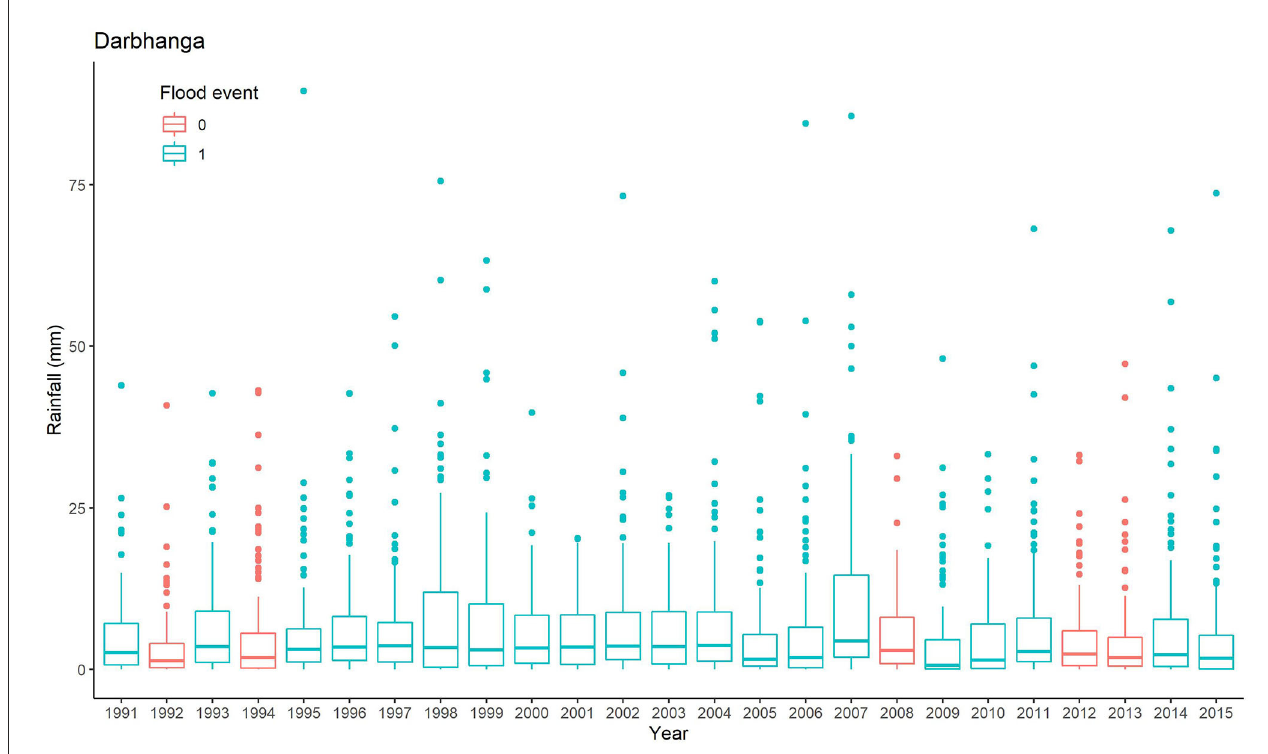
FIGURE4 Darbhanga_monthly rainfall_ flood events_(June-September).